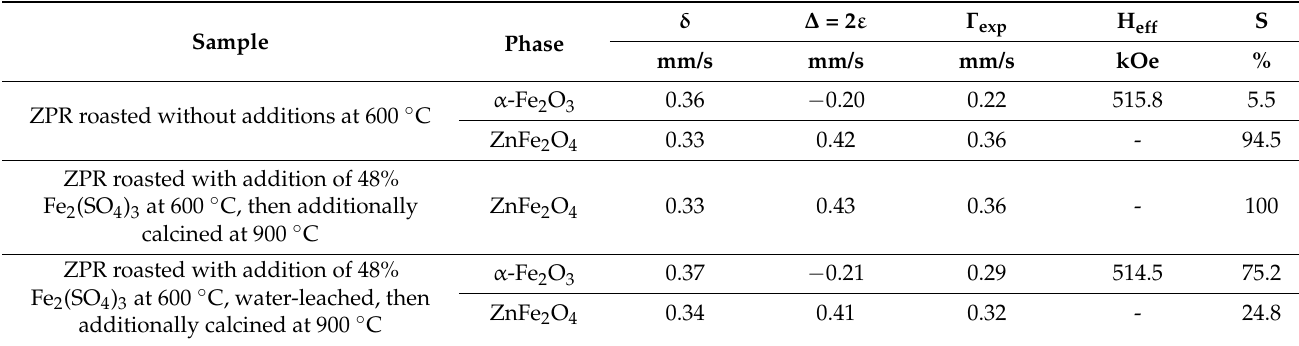
Table A1. Parameters 1 of the Mössbauer spectra collected at 296 K of ZPR samples treated at different conditions; roasting and calcination durations were 180 min.